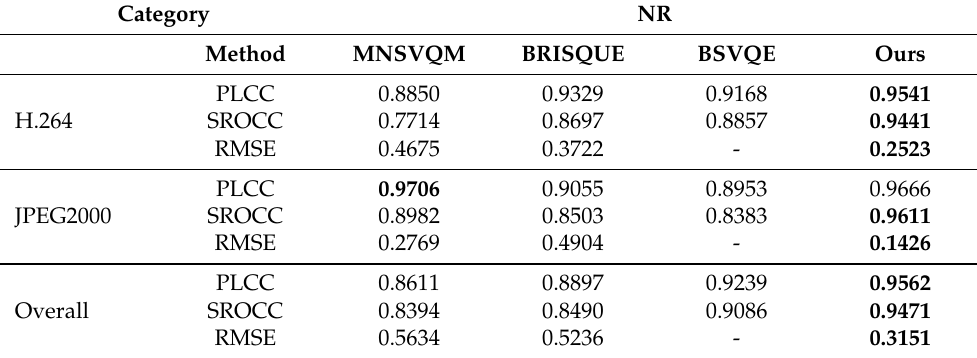
Table 4. Performance comparison of NR methods on QI-SVQA database. The best results are in bold.